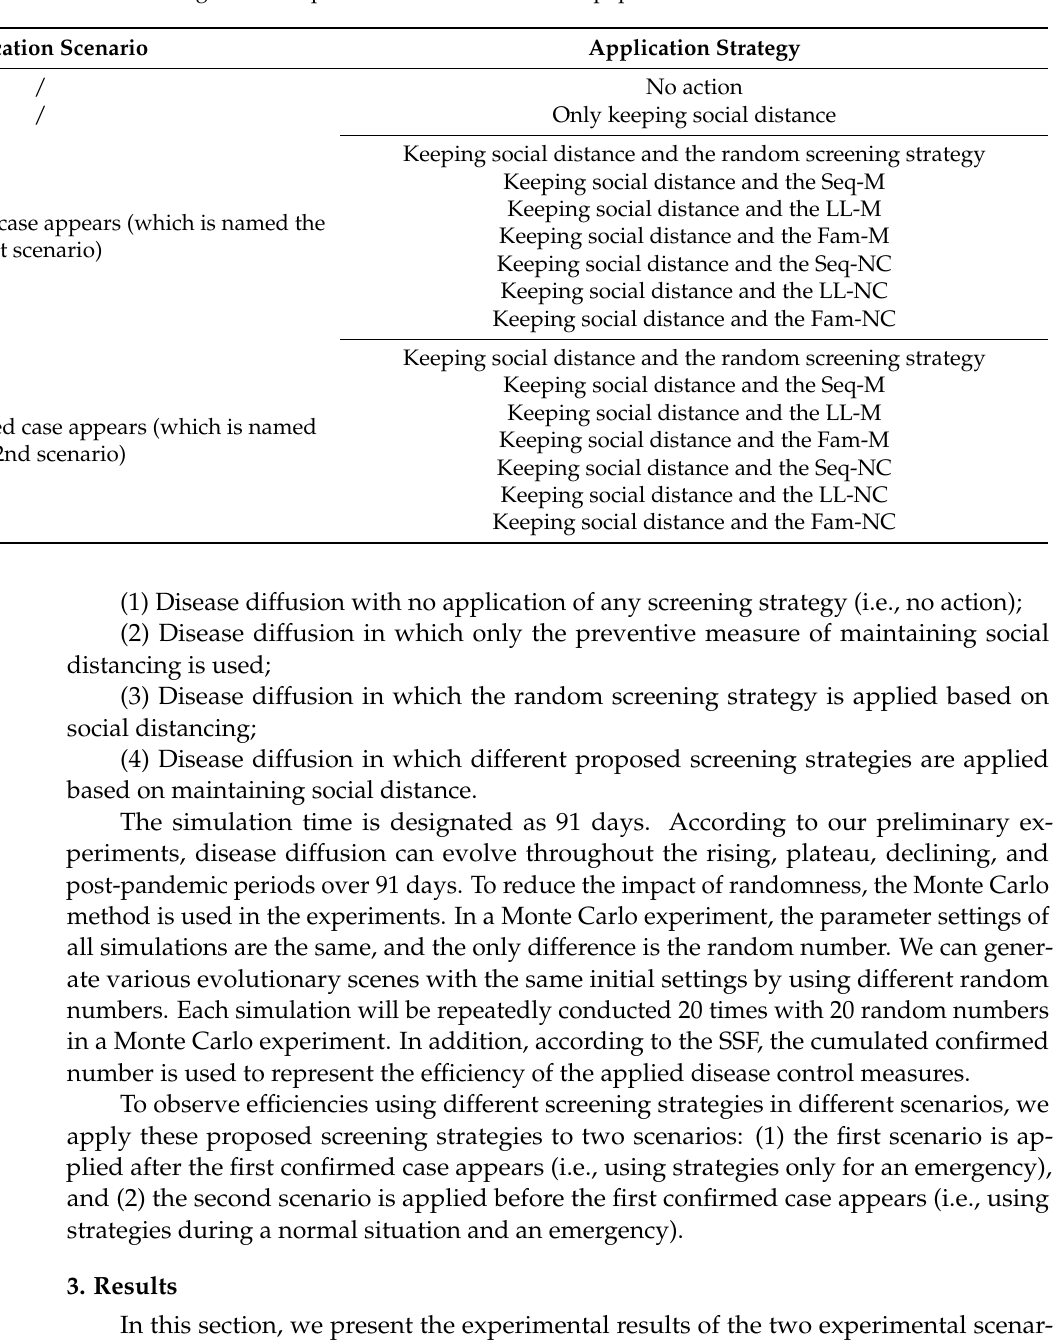
Table 2. Design of the experiments conducted in this